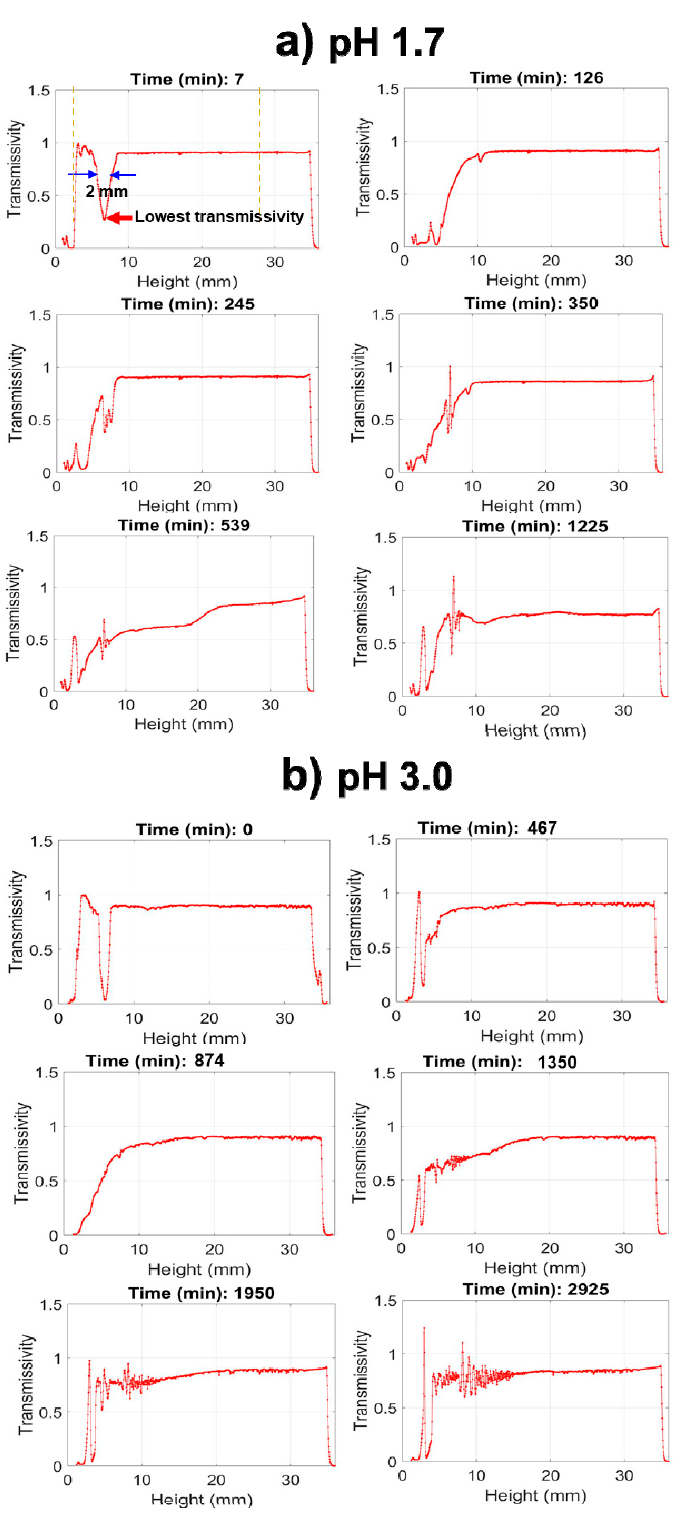
Figure 6. Turbidity scanning of the sol-gel reaction for 3F in water at pH 1.7 ( a ) and pH 3.0 ( b ). The graphs show light transmission vs. tube height, with 0 mm representing the bottom of the reaction tube. The lens of neat silane occupies the bottom ~2 mm of the 35 mm tube height, causing the dip in transmission seen at early times near the bottom of the tube. Hydrolysis solubilizes the silane, and the lens thickness narrows with time. Condensation in the bulk is observed by the drop in light transmission initially at the bottom and later through the entire length of the tube.